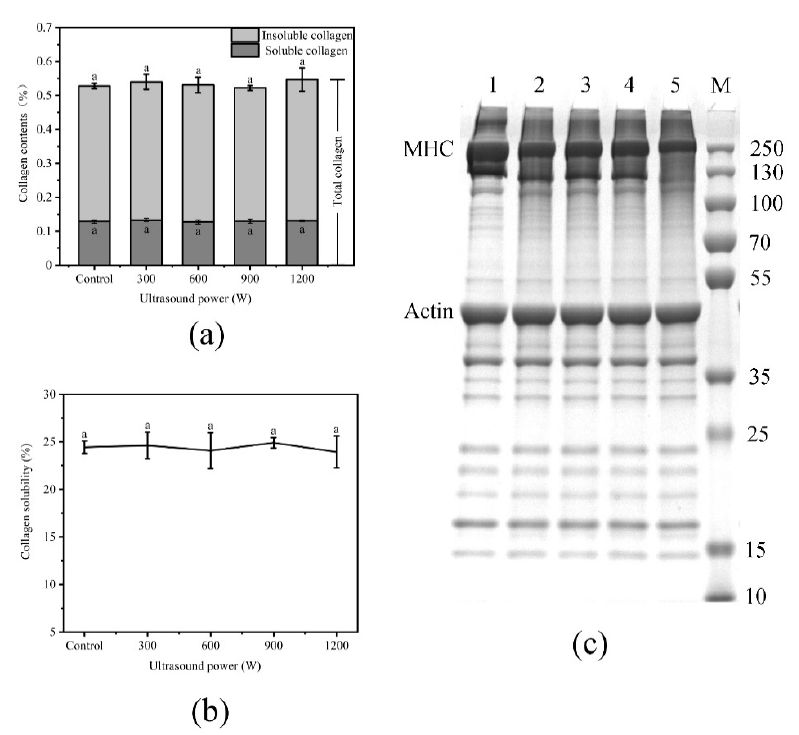
Figure 5. ( a ): Effect of different ultrasound power on collagen content of WB; ( b ): Effect of different ultrasound power on collagen solubility of WB; ( c ): Effect of different ultrasound power on Sodium Dodecyl Sulfate-Polyacrylamide Gel Electrophoresis (SDS-PAGE) of WB, 1–5: Control, 300 W, 600 W, 900 W, 1200 W; M: Marker. Error bars are standard deviations (n = 5). Different letters above columns represent a significant difference at p < 0.05.